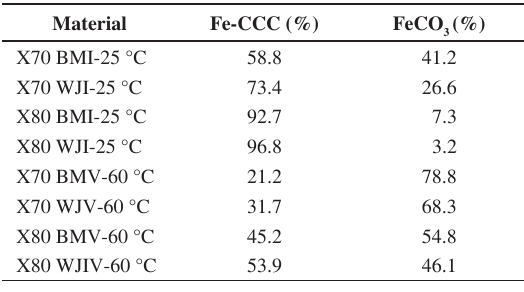
Table 3. Quantification of corrosion product by XRD.